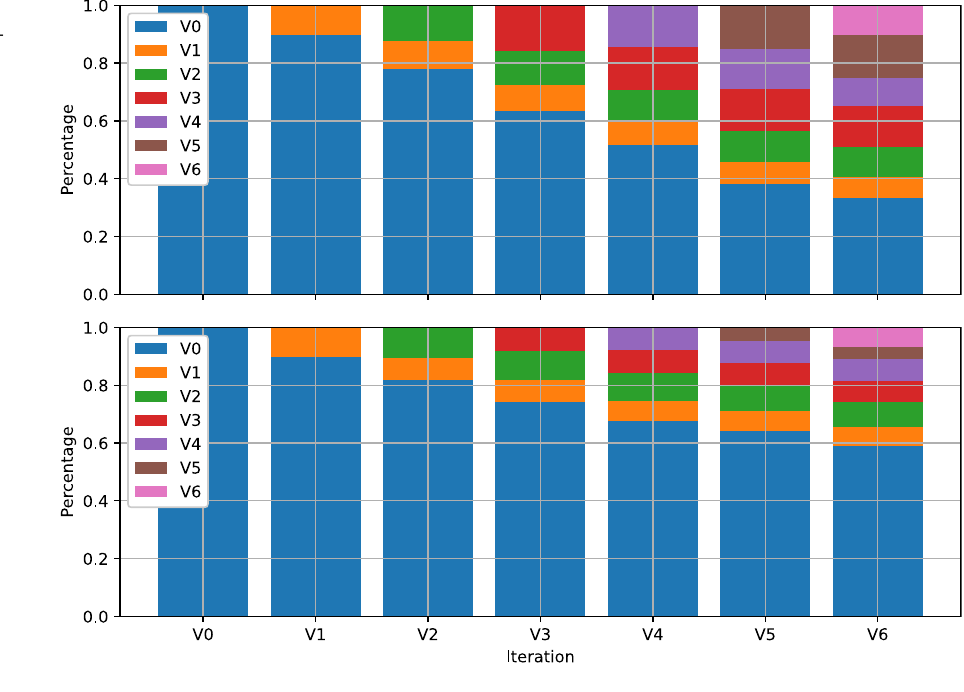
Fig. 3 Evolution of trees in